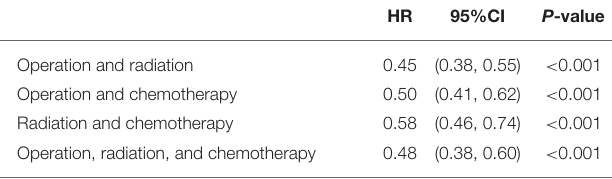
TABLE 3 | The Cox regression model of patient survival in patients with primary angiosarcoma in SEER database,